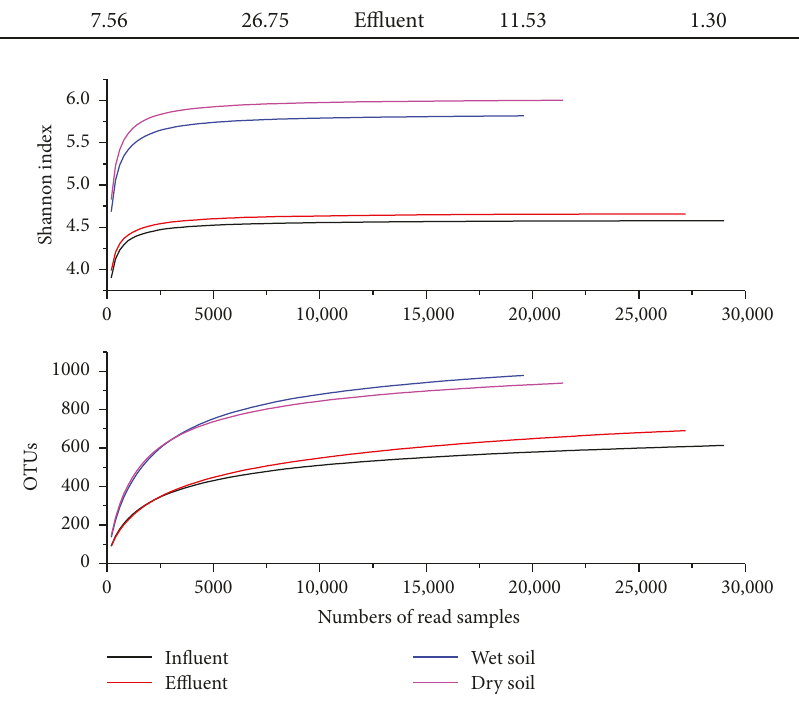
Figure 2: Bacterial rarefaction curves and Shannon diversity index